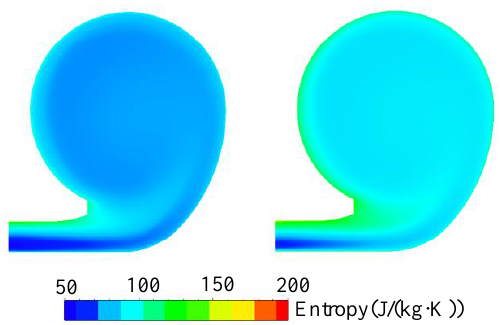
Energies 2017 , 10 , 2121